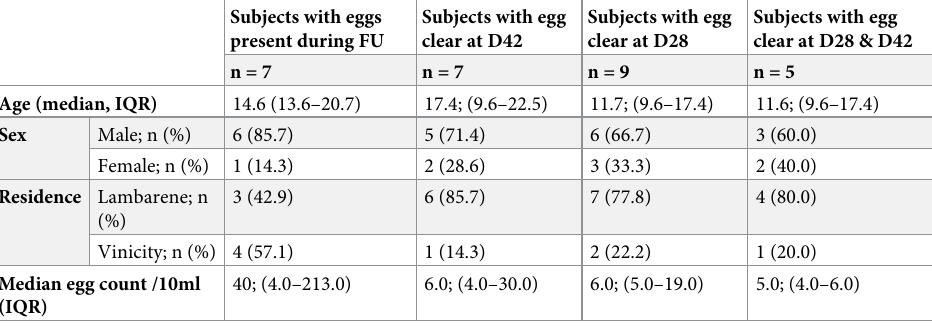
2 patients who cleared eggs at 4-weeks missed visit at 6-weeks; 2 patients cleared eggs only at 6 weeks; 2 patients